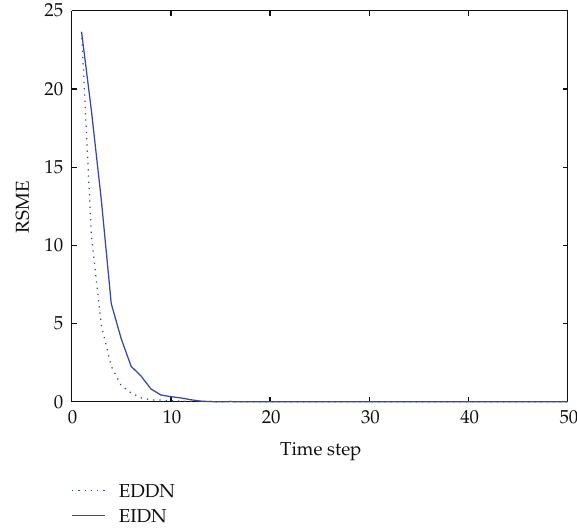
Figure 2: Plots of the RSME for the considered